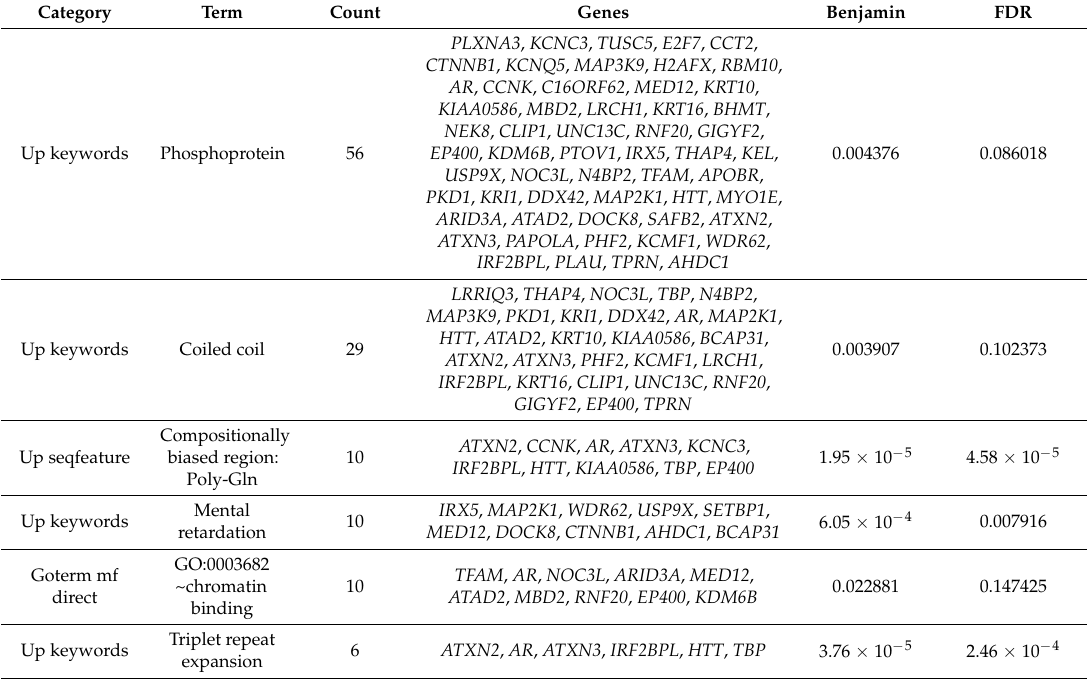
Table 4. Ontology terms and annotations of indels adding SNPs